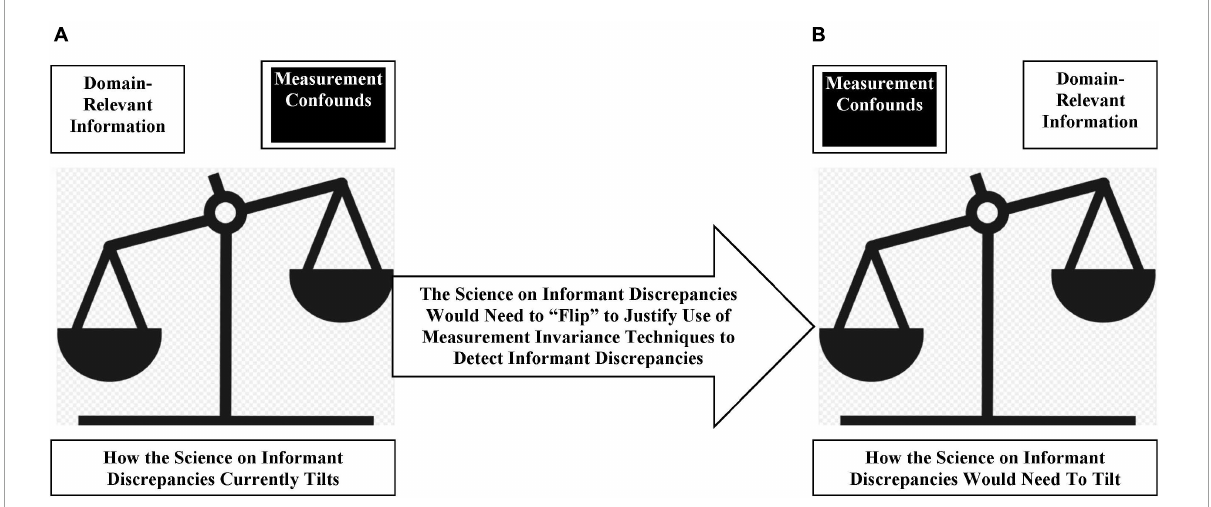
FIGURE4 How the state of the science on informant discrepancies in youth mental health assessments would need to tilt to justify the use of measurement invariance techniques to detect informant discrepancies. (A) Depicts the current state of the science on these discrepancies, which clearly tilts in favor of informant discrepancies more likely reflecting domain-relevant information rather than measurement confounds. To justify the use of the measurement invariance techniques to detect informant discrepancies in youth mental health assessments would require theory and evidence that renders informant discrepancies synonymous with measurement confounds. This would require a complete “flip” of the theoretical and evidentiary bases of informant discrepancies as they manifest in youth mental health assessments (B) , such that the state of the science would need to clearly tilt in favor of the likelihood that informant discrepancies in youth mental health assessments reflect measurement